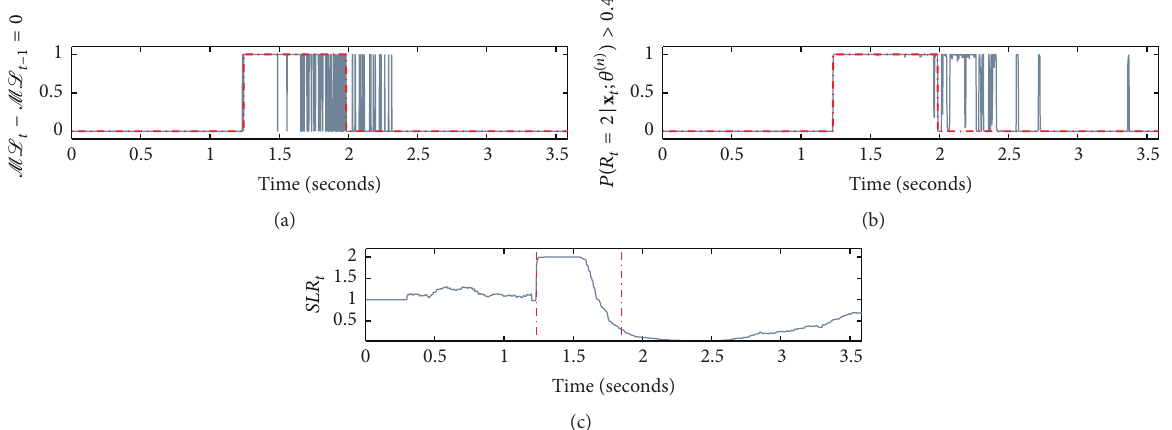
Figure 12: The application of the discussed methods to real dataset consisting of single seismic event. The final segments have been marked by using bold red-dashed curves. (a) The application of the smoothing procedure used for segmentation purposes based on ML 𝑡 statistics. The grey curve depicts the nonsmoothed segments. (b) The application of the smoothing procedure to the vector of probabilities of being in the second regime with the boundary threshold set to 0.4. The grey curve denotes the nonsmoothed vector of probabilities. (c) Sequence of the test statistics 𝑆𝐿𝑅 𝑡 , where the short and long time windows are equal to 0.3 s and 1.2s, respectively; the activation 𝜏 𝐴 and deactivation 𝜏 𝐷 thresholds corresponding to 1.6 and 0.3, respectively.